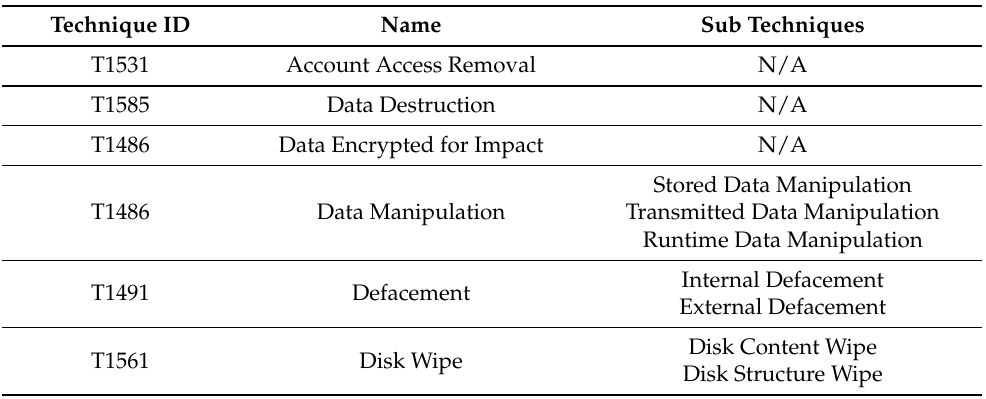
Table 5. MITRE ATT&CK Impact